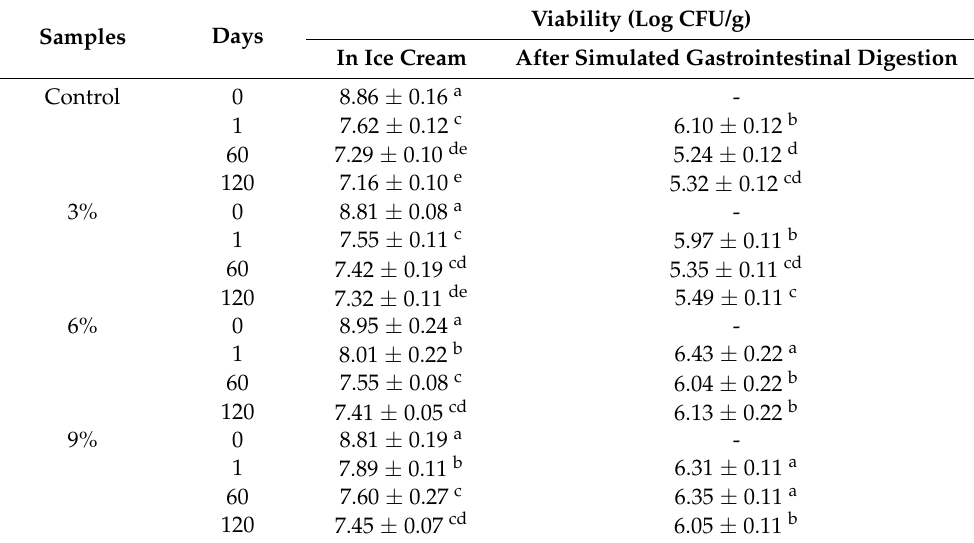
Table 5. Viability of Bifidobacterium lactis in the ice creams and after simulated gastrointestinal digestion during